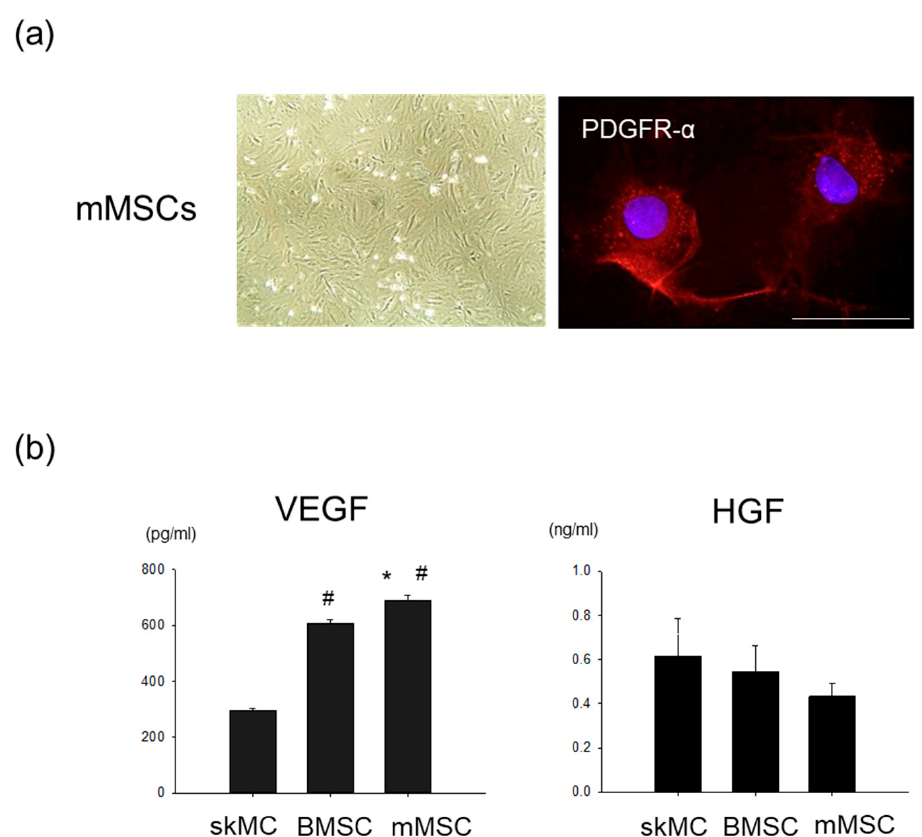
Figure 1. Production of angiogenic cytokines in mMSCs. ( a ) Representative microscopic images of the mMSCs. Left phase contrast image. Original magnification × 40. Right, red fluorescence indicates PDGFR- α . PDGFR- α was ubiquitously expressed in the mMSCs. Nuclei were stained with DAPI (blue). Bar = 50 µ m. ( b ) Concentration levels of VEGF and HGF in the conditioned medium. N = 6. * p < 0.05 vs. BMMSCs. # p < 0.01 vs. skMCs. mMSCs, mesenchymal stem/stromal cells derived from skeletal muscle; PDGFR- α , platelet-derived growth factor receptor- α ; DAPI, 4’,6-Diamidino-2- phenylindole; VEGF, vascular endothelial growth factor; HGF, hepatocyte growth factor; BMMSCs, bone marrow mesenchymal stem/stromal cells; skMCs, skeletal muscle